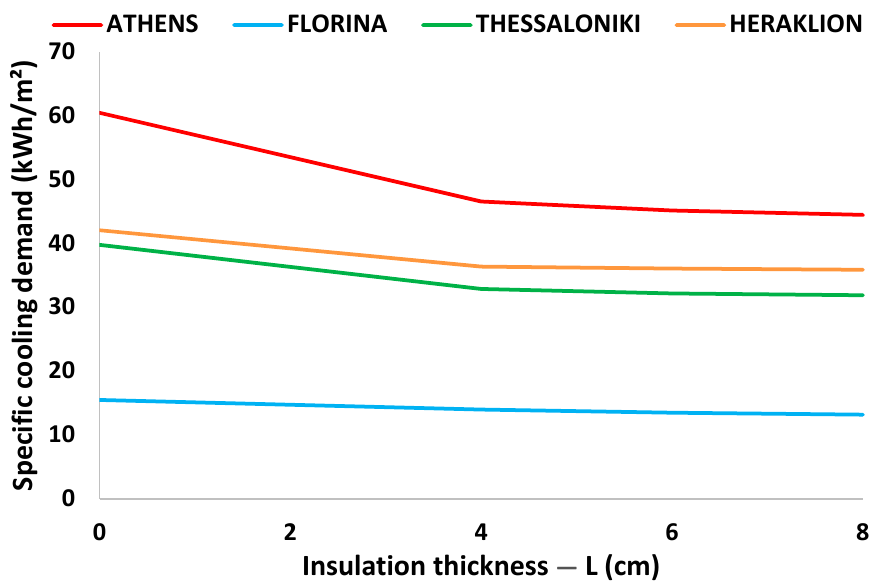
Figure 4. Specific cooling demand for the examined cases.